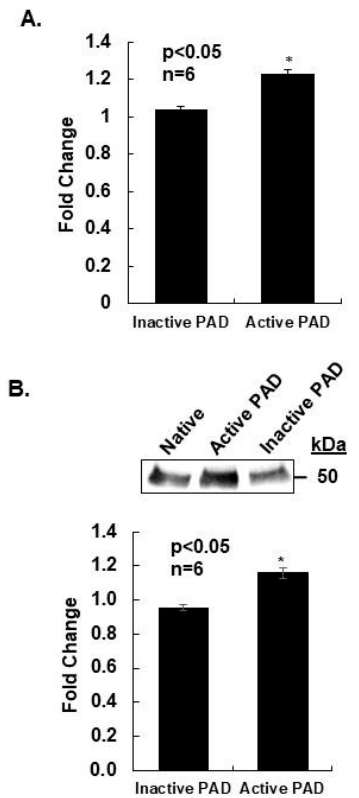
Figure 6. Citrullination altered tubulin polymerization rates. ( A ) Purified porcine brain tubulin was incubated with vehicle (native), purified PAD enzyme with calcium (active PAD), or purified PAD enzyme without calcium (inactive PAD). Native, active PAD, and inactive PAD tubulin samples were polymerized into microtubules and rates measured every 20 s through the entire polymerization range until steady-state equilibrium was reached. The tubulin polymerization Vmax was calculated as the maximum 5 min average slope of polymerization for all three samples. The active PAD and inactive PAD Vmax values are represented as fold change compared to native tubulin Vmax. All values are expressed as the mean ± SEM. Means were separated using Student’s t -test and * indicates significantly di ff erent means ( n = 6, * p < 0.05). ( B ) After completion of the polymerization assay, 4 µ gs of native, active PAD, and inactive PAD tubulin samples were labelled with biotin-PG and examined by Western blot. The top panel shows a representative Western blot, while the bottom panel represents the quantification of multiple Western blots using ThermoFisher iBright Analysis software. Densitometry results for citrullinated tubulin for active PAD and inactive PAD samples were normalized to native tubulin to allow for comparison across di ff erent experiments. Data are presented as means +/ − SEM and separated using the student Student’s t -test ( n = 6, * p <